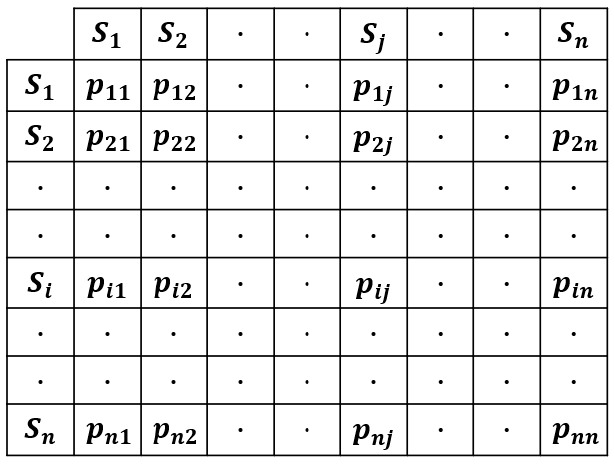
7 of 18 Figure 4. Operational boundaries of the ESS-based control. 3.2. Estimation of 1-Min Load Variations